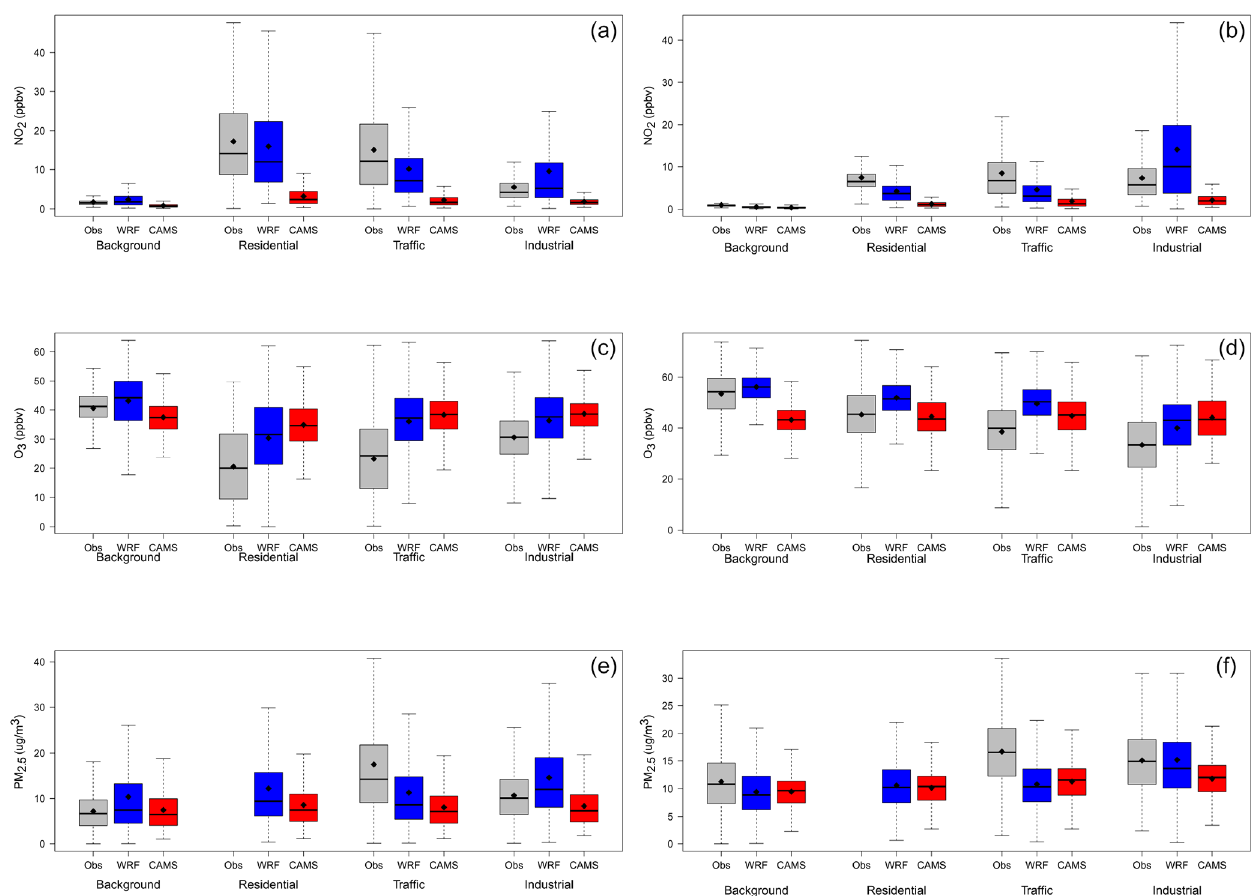
Figure 4. Box-and-whisker plots at the background, residential, traffic, and industrial NO 2 (a, b) , O 3 (c, d) , and PM 2 . 5 (e, f) average mixing ratios in observed data (grey colour) and the WRF-Chem (blue colour) and CAMS (red colour) forecasts during winter (a, c, e) and summer (b, d, f) . The seasonal average mixing ratios are derived from hourly mixing